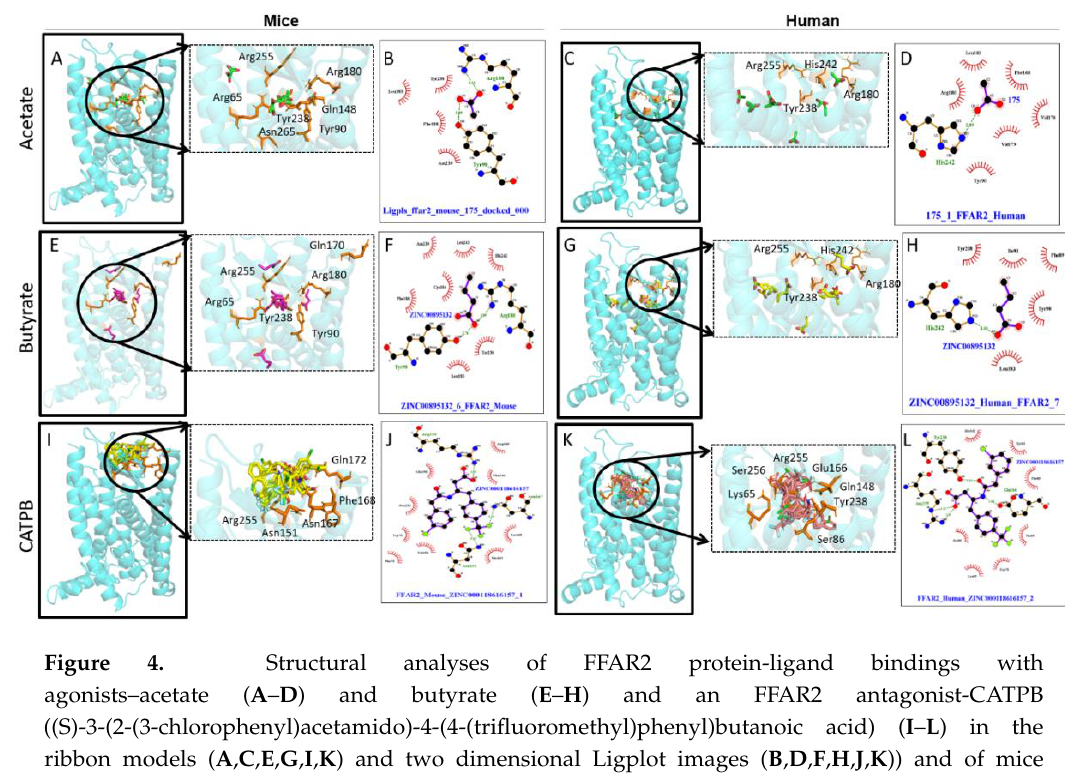
Figure 4. Structural analyses of FFAR2 protein-ligand bindings with agonists – acetate ( A ‒ D ) and butyrate ( E ‒ H ) and an FFAR2 antagonist-CATPB ((S)-3-(2-(3-chlorophenyl)acetamido)-4-(4-(trifluoromethyl)phenyl)butanoic acid) ( I ‒ L ) in the ribbon models ( A , C , E , G , I , K ) and two dimensional Ligplot images ( B , D , F , H , J , K )) and of mice ( A , B , E , F , I , J ) and human ( C , D , G , H , K , L ).